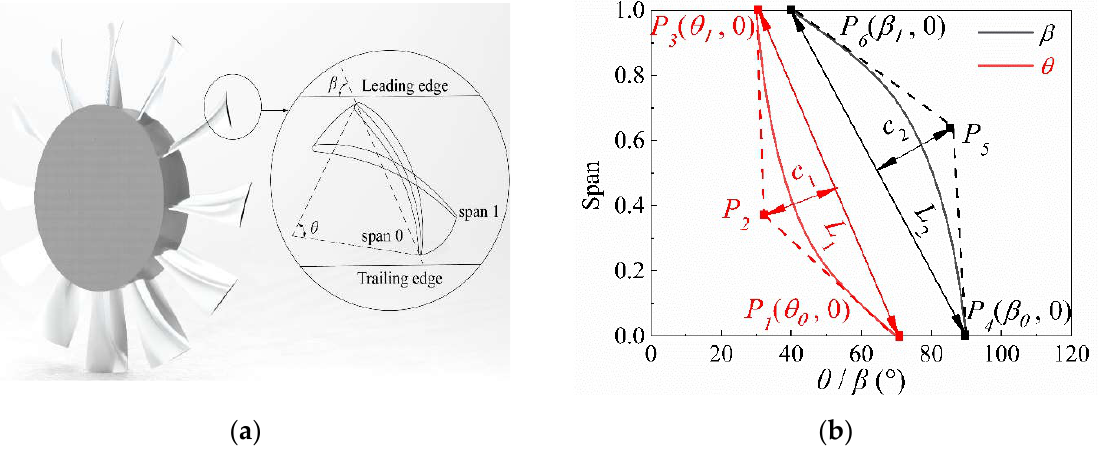
Figure 2. Axial flow fan blade modeling method: ( a ) 3D impeller model and the position of θ and β ; ( b ) the radial distribution of θ and β .